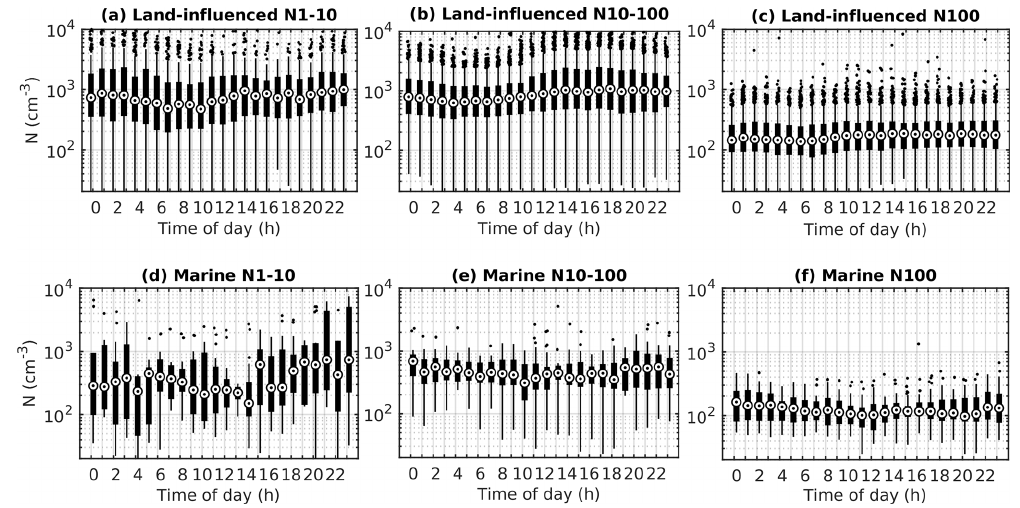
Figure 6. Diurnal cycles of particle number concentrations ( N ) in size ranges of 1–10nm, 10–100nm, and above 100nm separated into marine and land-influenced air. The circles are the median concentrations, black boxes mark the 25th and 75th percentiles, the whiskers mark 1.5 times the interquartile range, and the rest of the points are outside this